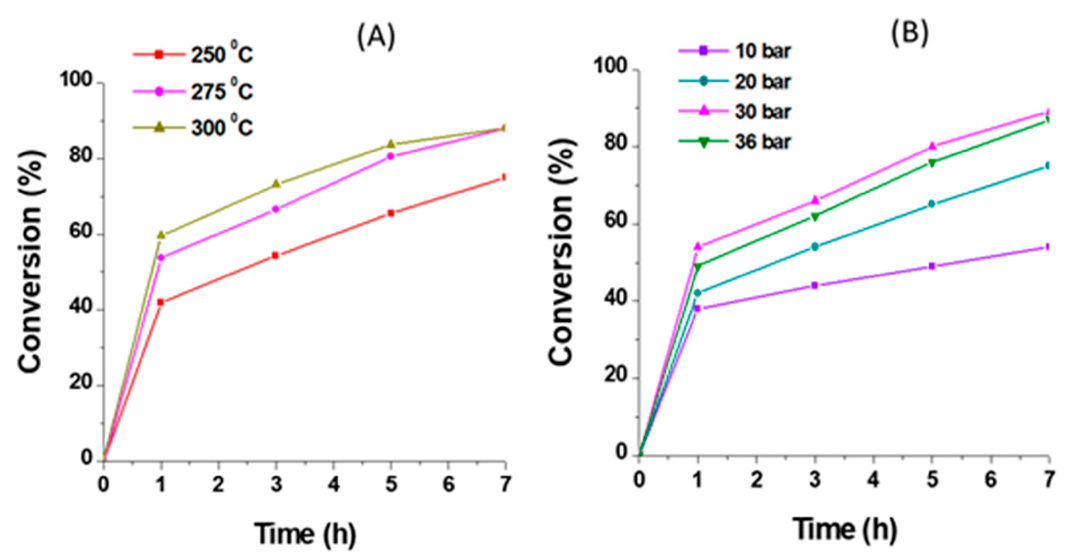
Figure 6. Conversion vs. time for 1.3 wt% Pd/TiO 2 nano catalyst in tars mild hydrotreatment: ( A ) At 30 bar of H 2 , 0.2 g catalyst, during 7 h; ( B ) At 275 °C, 0.2 g catalyst, during 7 h.